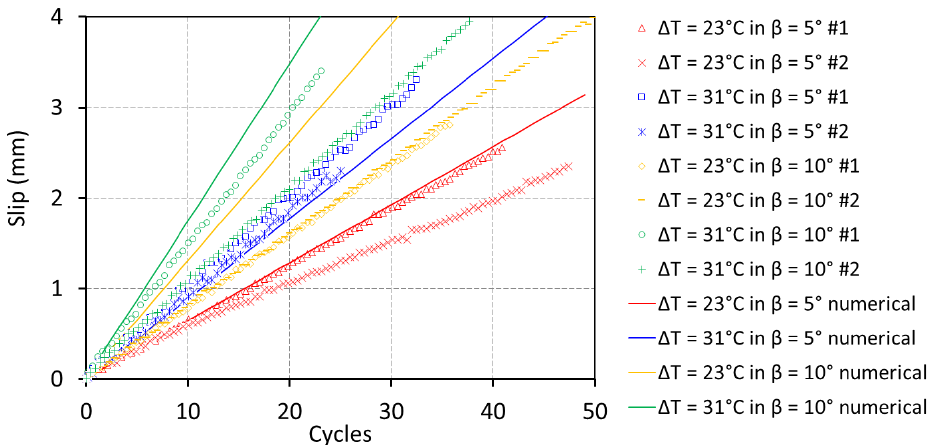
Figure 7. Comparison of experiments and simulations—solid lines are the residual traces of numerical results and all the discrete markers are the experimental results.